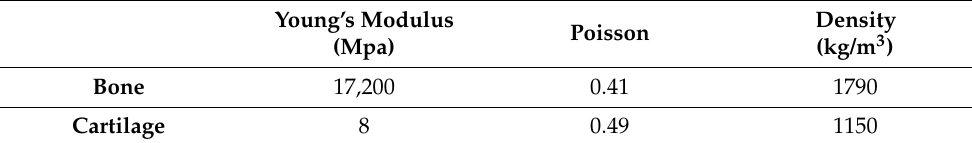
Table 1. Tissue properties for bones and cartilages.